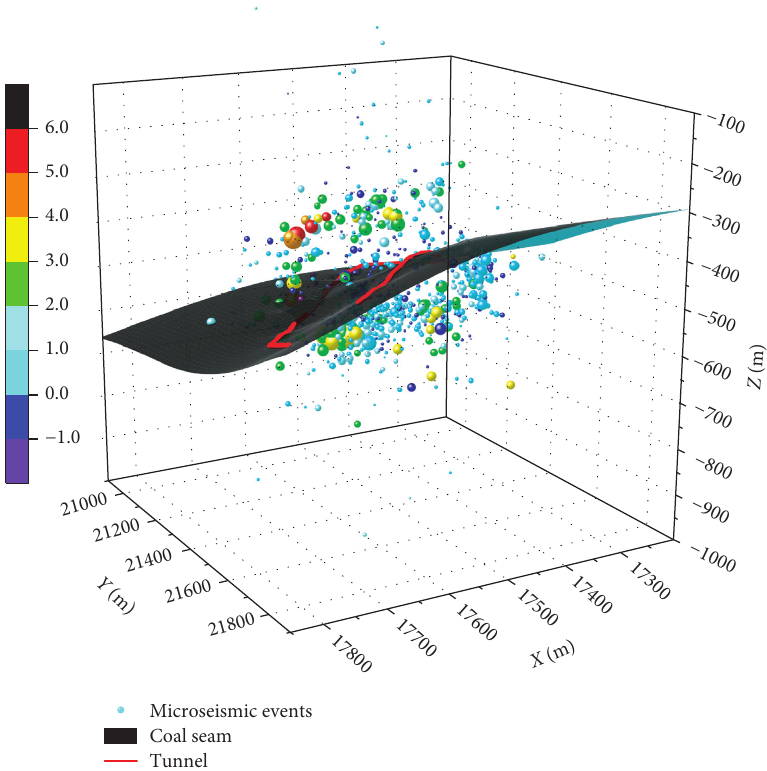
Figure 10: Spatial distribution map of microseismic events after mining.